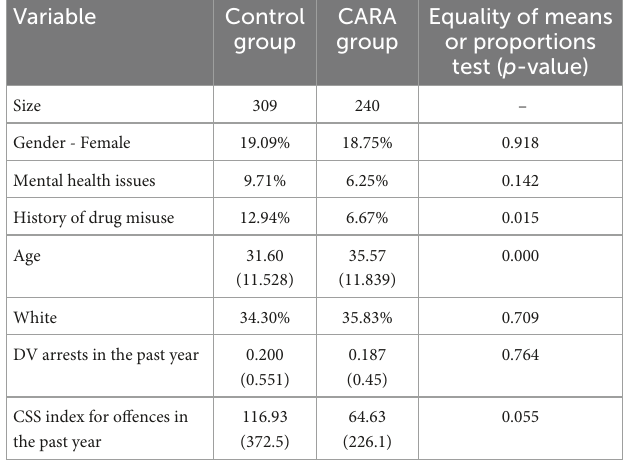
TABLE 6 Hampshire constabulary data descriptive statistics–Means of offender crime